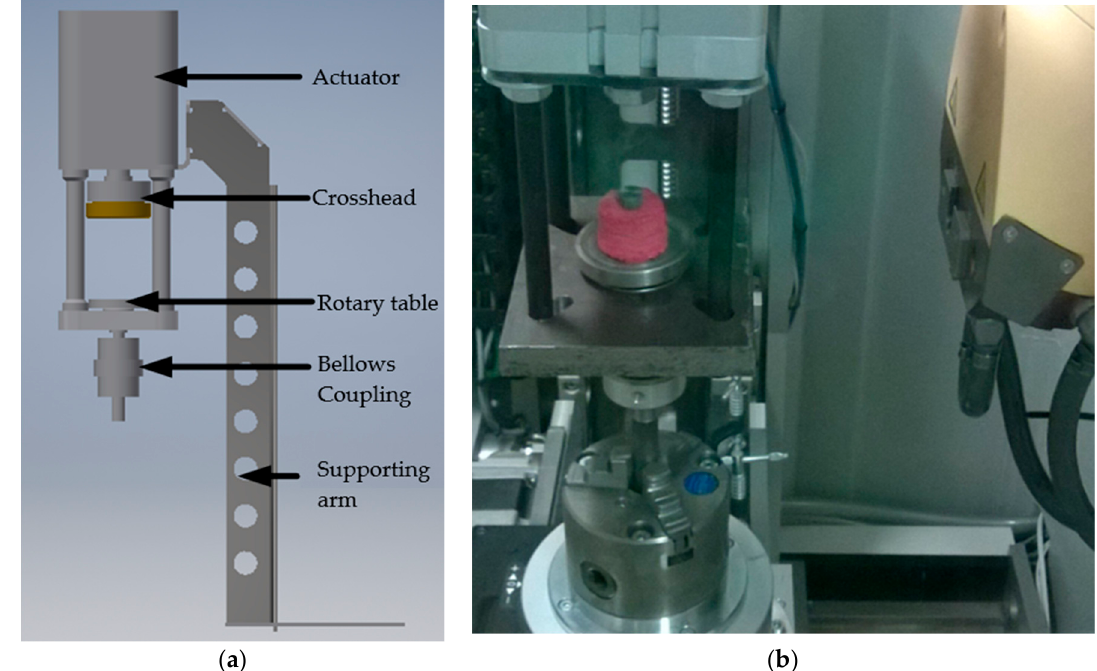
Figure 5. ( a ) The CAD model of the executive system that enabled mechanical tests; ( b ) A representative bone-implant specimen in the chamber of the micro-CT scanner.